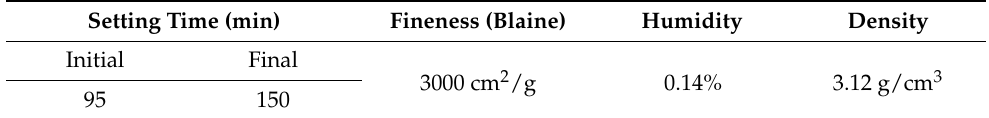
Table 1. Physical properties of cement.